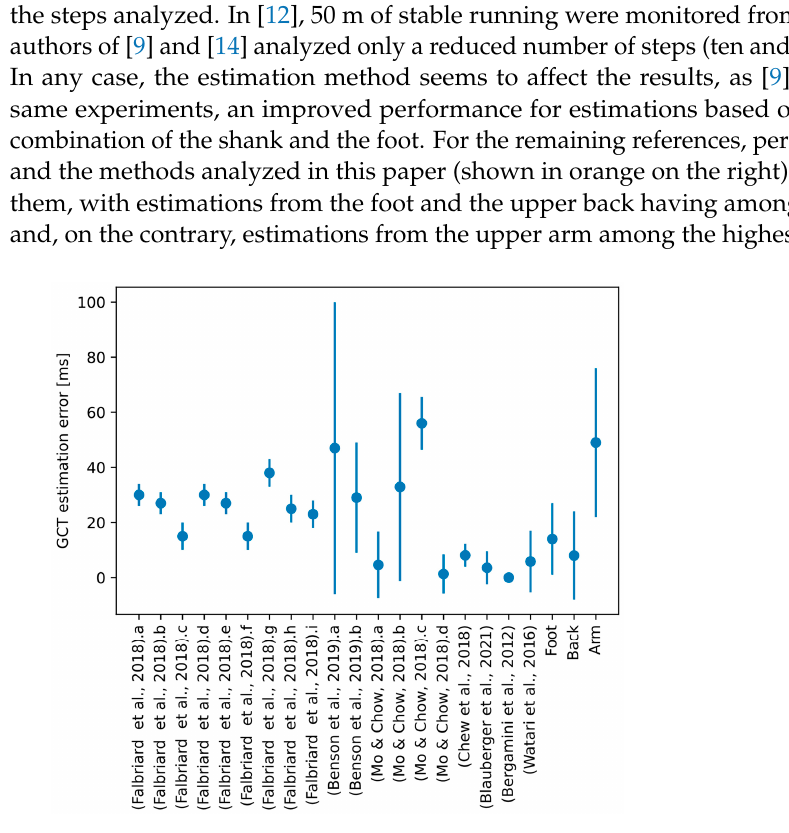
Figure 9. Error bars (accuracy ± precision) reported in the references analyzed from the state of the art and the methods proposed in this paper. X-axis labels show the reference and a letter (as indi- cated in Table 1) referencing the specific estimation method when different techniques are proposed in the same work. The last three values correspond to the methods proposed in this paper (using IMUs at the foot, the upper back, and the upper arm). References: (Falbriard et al., 2018), [7]; (Ben- son et al., 2019), [8]; (Mo & Chow, 2018), [9]; (Chew et al., 2018), [11];(Blauberger et al., 2021), [12]; (Bergamini et al., 2012), [14]; (Watari et al., 2016), [15].